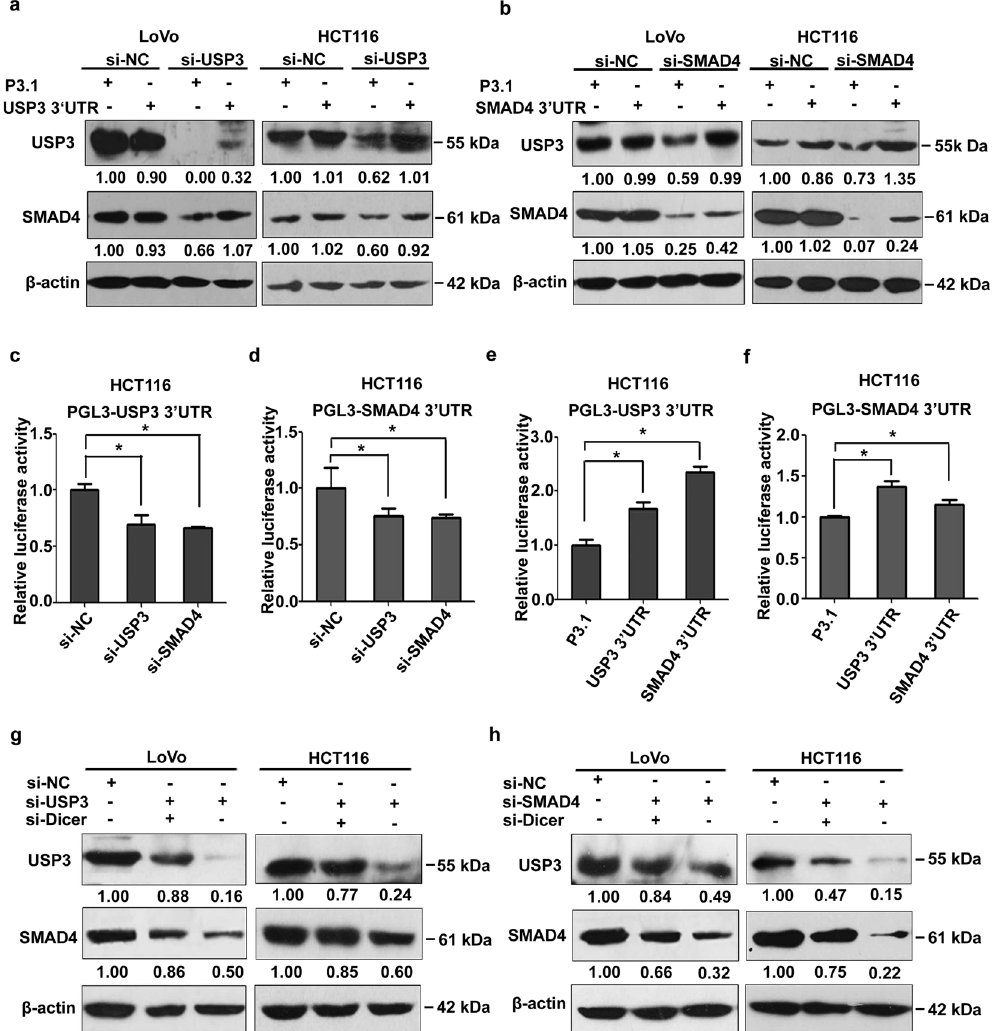
Figure 2. Crosstalk between USP3 and SMAD4 was 3 ′ UTR and miRNA dependent. ( a,b ) USP3 3 ′ UTR or SMAD4 3 ′ UTR mutually modulated protein expression of the other when endogenous USP3 or SMAD4 expression was first reduced by siRNA transfection. ( c,d ) Deletion of USP3 or SMAD4 attenuated luciferase activity of the PGL3-USP3 3 ′ UTR or PGL3-SMAD4 3 ′ UTR reporters; ( e,f ) overexpression of USP3 3 ′ UTR or SMAD4 3 ′ UTR increased the luciferase activity of the corresponding reporter plasmids. ( g,h ) USP3 and SMAD4 expression was elevated when Dicer depletion was combined with USP3 or SMAD4 knockdown, compared with treatment of si-USP3 or si-SMAD4 alone. All values are represented as the mean ± SD (n = 3). Western blot images are cropped; full-length blots are included in Supplementary Figure S11 to S14. Quantitative protein expression data were normalized to β -actin. * P <